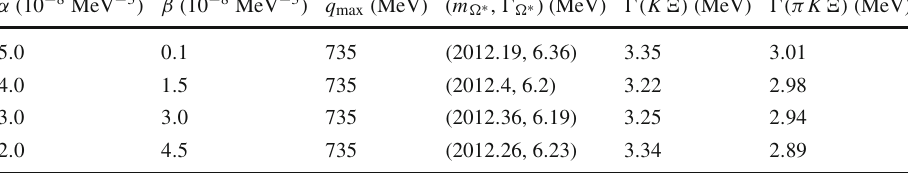
Table 5 Varying the parameter α we fit β , q max to the data and then calculate (cid:17)( ¯ K (cid:3)) and (cid:17)(π ¯ K